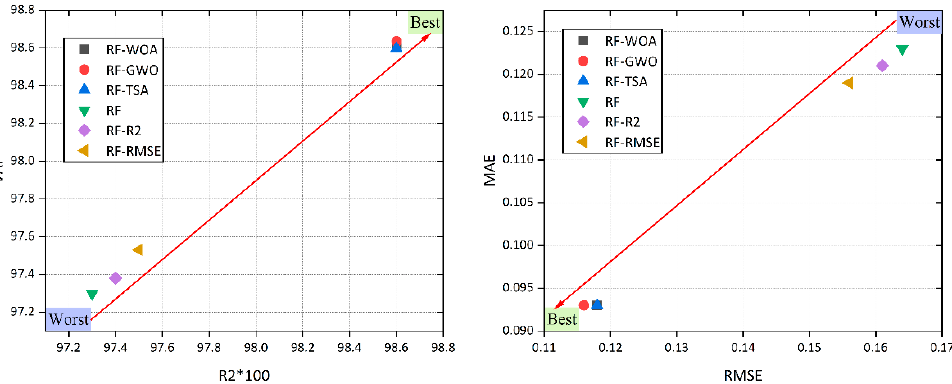
Figure 8. Results of the evaluation metrics of the developed models on the training set.